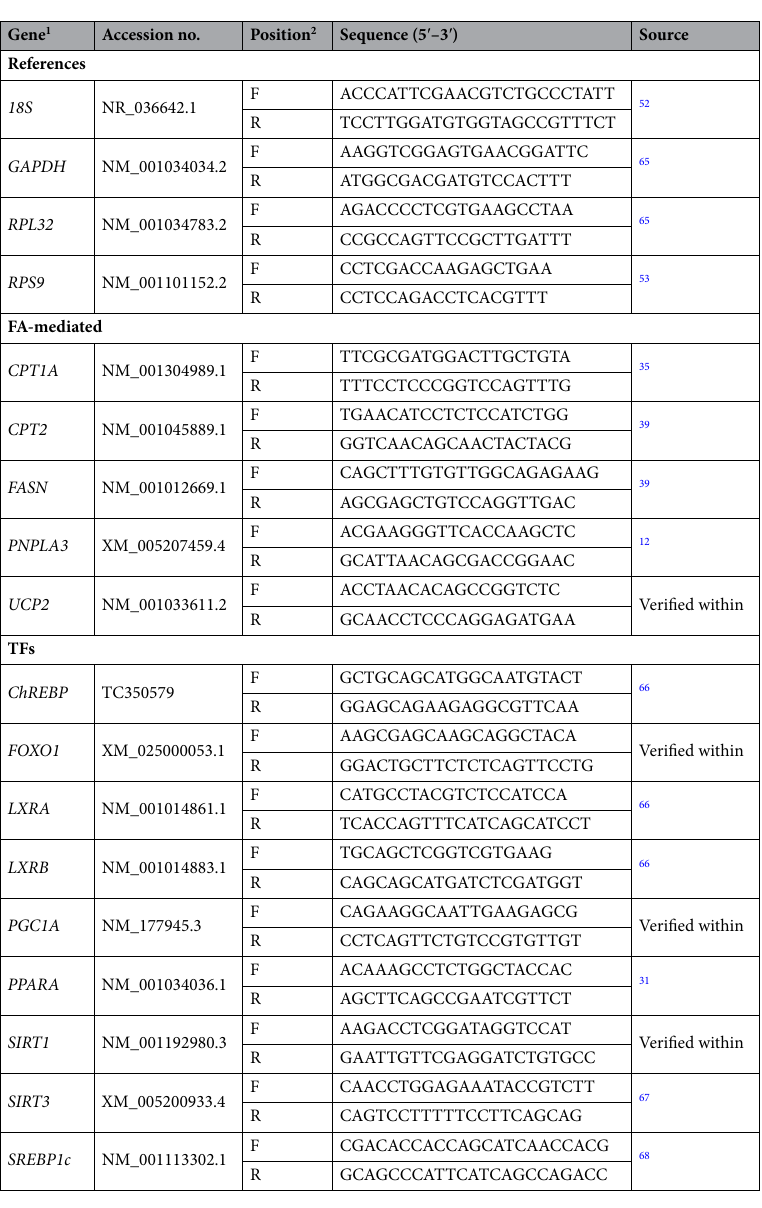
Table 3. Primers used for real time-quantitative PCR organized by function: reference, fatty acid (FA)- mediated, and transcription factor (TFs)